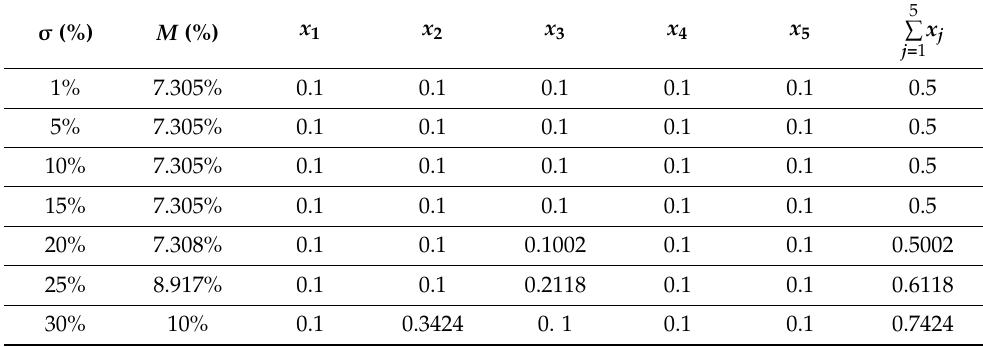
Table 5. The possibilistic efficient portfolios with b = 0.1, p 1 = 0.4, p 2 = 0.1, p 3 =